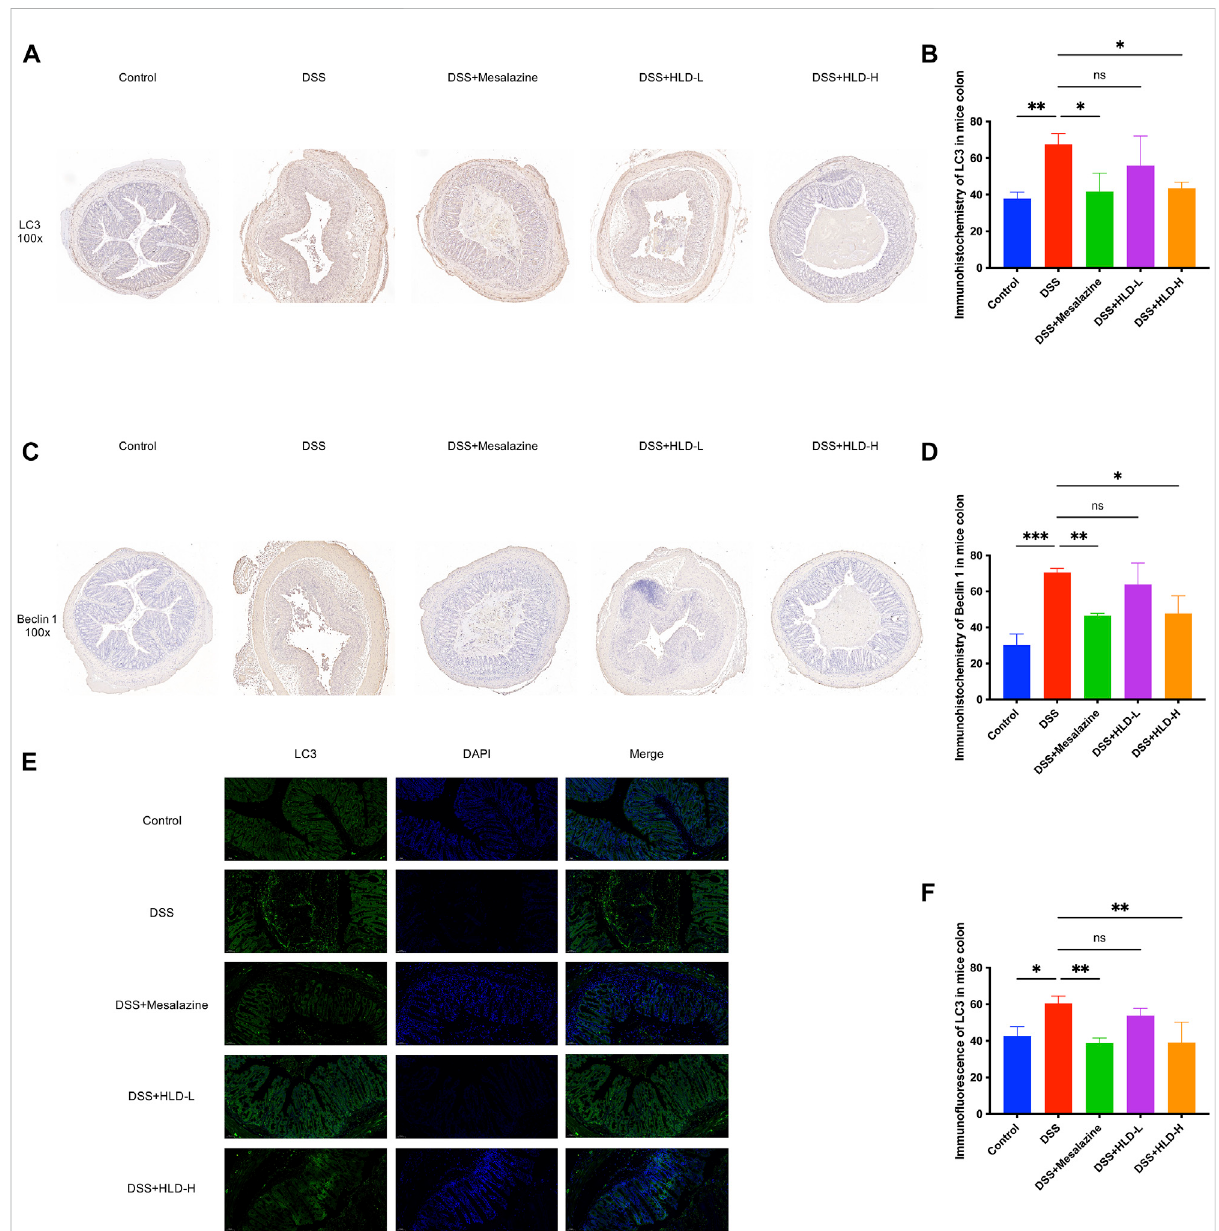
FIGURE 5 HLD exerted anti-in fl ammatory effects by inhibiting autophagy in vivo . (A , B) Comparison of immunohistochemistry of LC3 in mice colonic tissues. (C , D) Comparison of immunohistochemistry of Beclin 1 in mice colon tissues. (E , F) LC3 expression in mice colonic tissues detected by immuno fl uorescence. All data were expressed as the mean ± SD. ( n = 3). * p < 0.05, ** p < 0.01, *** p <